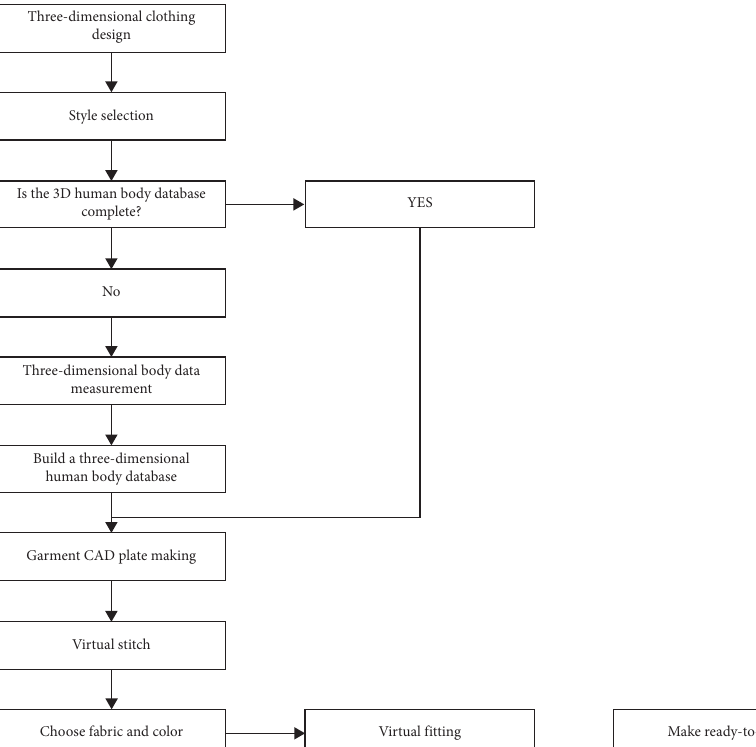
Figure 2: The six-in-one digital process system of measuring, drawing, sewing, fitting, modifying, and making.